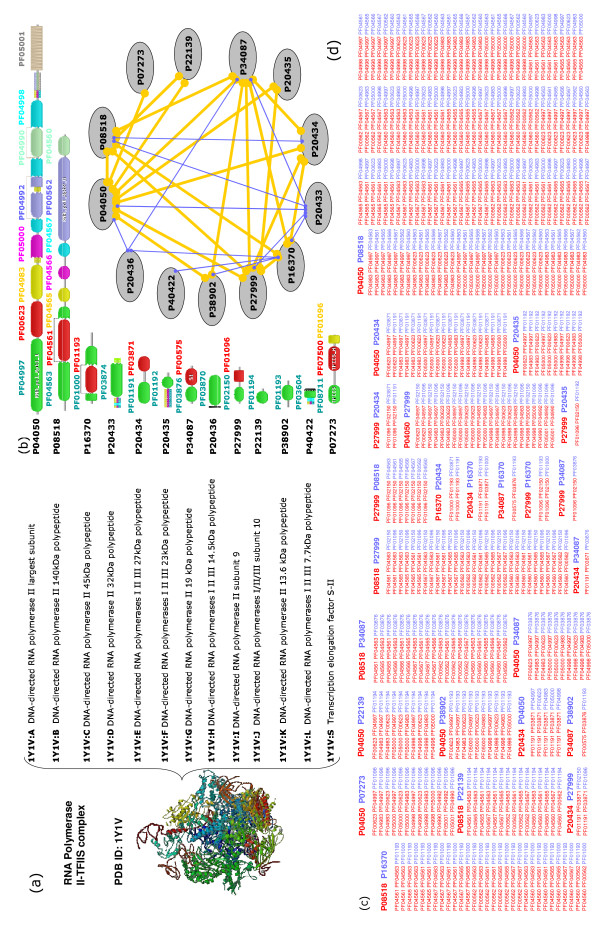
Reconstruction of DNA-directed RNA polymerase complex. (a) The RNA Polymerase II-TFIIS complex (PDB ID 1y1v) with 13 subunits (from chain A to chain S). Every chain is one protein (shown by their UniProtKB accessions) and their complex interactions form the large polymer. (b) The PfamA domain architecture for every protein. (c) The cooperative domains identified by our method with protein interaction pairs containing them. The red or blue colors of proteins and domains indicate their memberships.